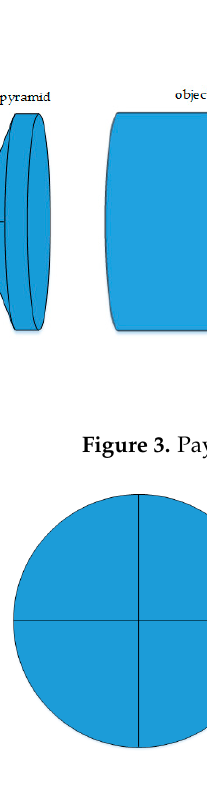
Figure 4. The four-facet round-base pyramid concept.